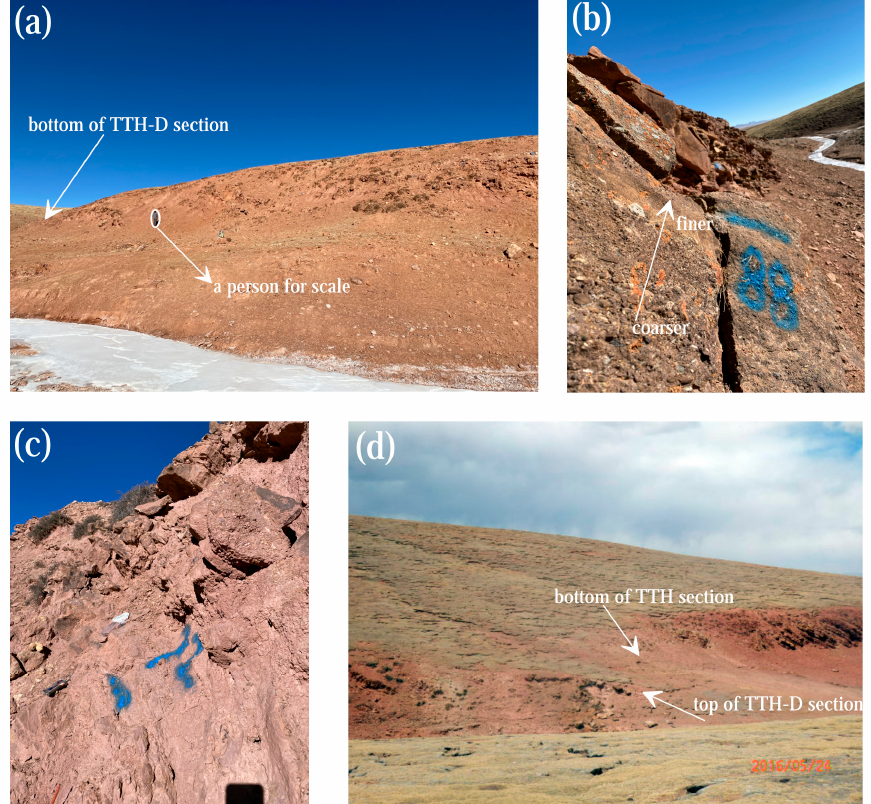
Figure 2. Field photographs of the TTH-D section. ( a ) The bottom of the TTH-D section. ( b ) Graded bedding of the Tuotuohe Formation. ( c ) The central part of the TTH-D section is composed of sandstone and conglomerate-containing sandstone. ( d ) The top of the TTH-D section and the bottom of the TTH section.